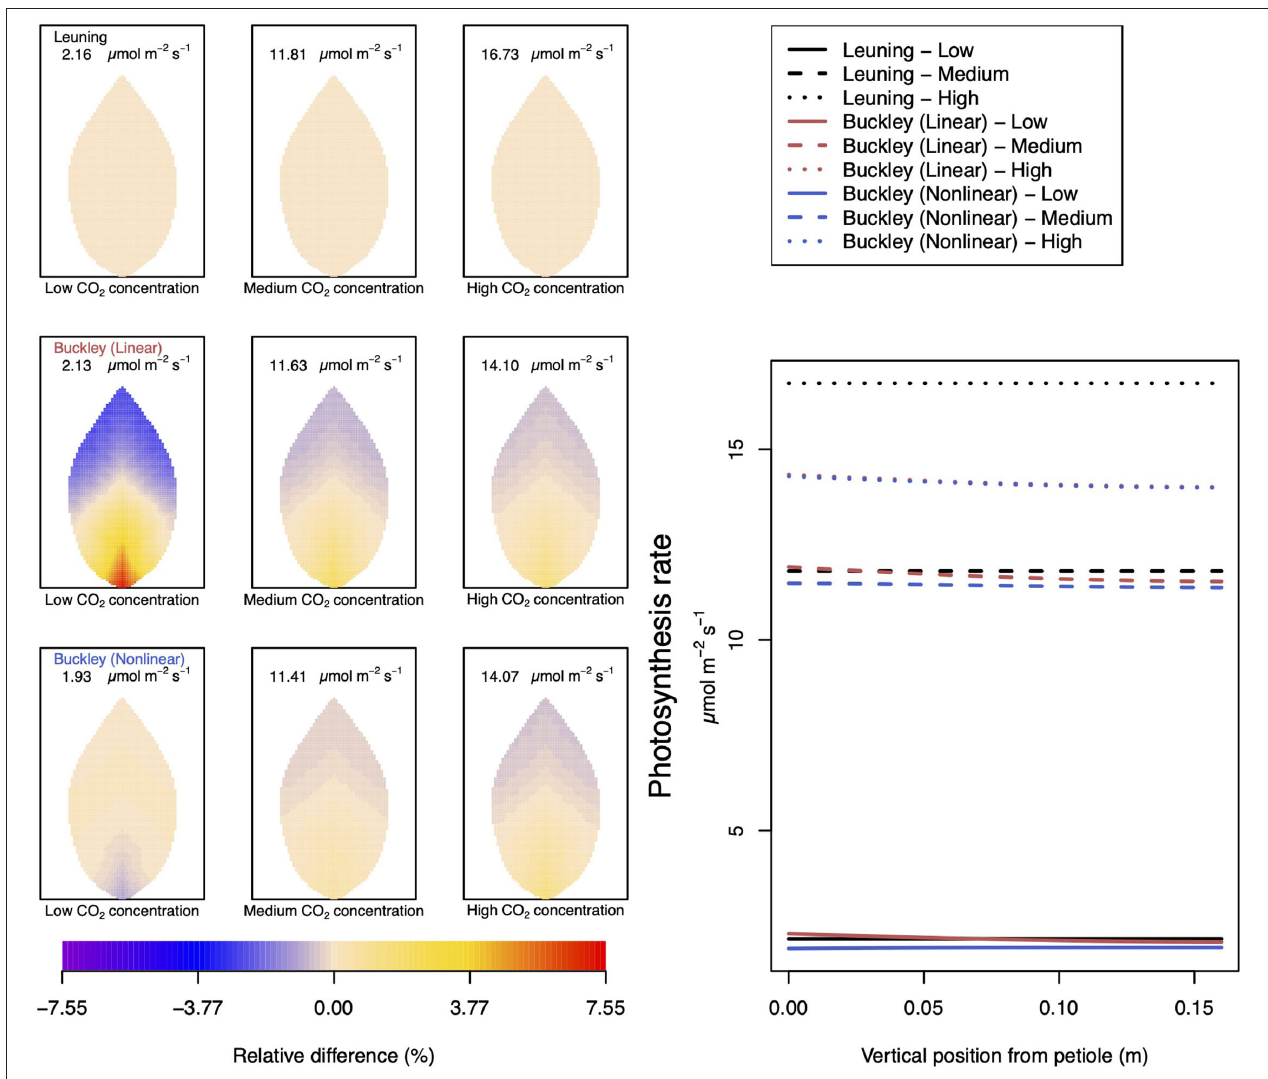
FIGURE 4 | A comparison of predictions of photosynthetic activity distributed over the leaf according to the three stomatal conductance models of Leuning (1995) (top row of panels and black lines in right hand figure), linear (Buckley et al., 2003) (middle row of panels and red lines in the right hand figure), and nonlinear (Buckley et al., 2003) (bottom row of panels and blue lines in right hand figure). The 2D maps shown are deviations from leaf-area averages. The leaf-area average values of photosynthesis rates are given at the top of each panel. The three columns (left-to-right) and line styles (solid, dashed, dotted) show the respective dependencies on the external gas concentration of CO 2 : low (100 ppm), medium (400 ppm), and high concentration (800 ppm). Other model parameter values can be found in Supplementary Information I